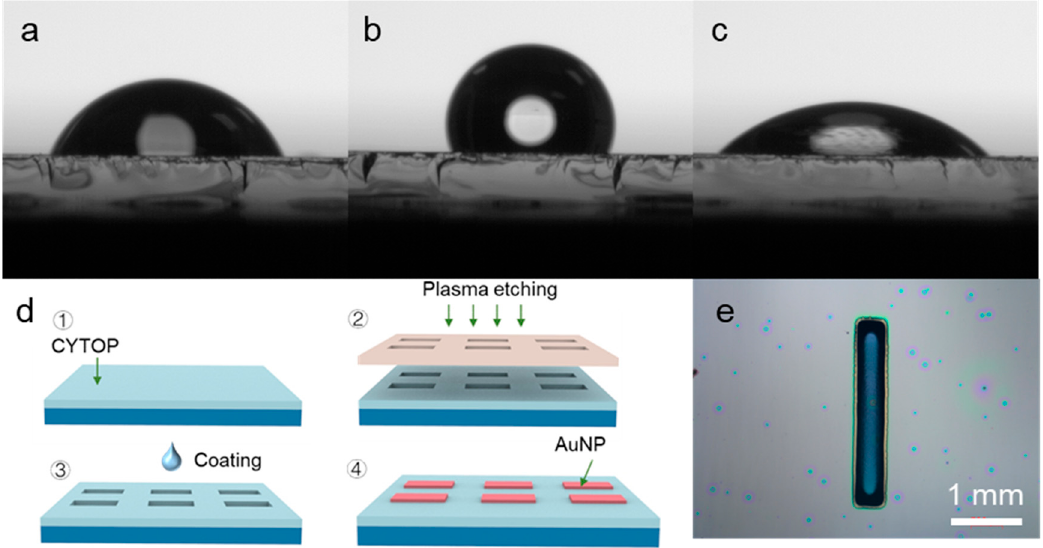
Figure 2. Contact angle images of the glass substrate at the different stations: ( a ) untreated, ( b ) coating Cytop, ( c ) after plasma treatment. ( d ) Schematic illustration of the fabrication of the patterned NPG electrodes. ( e ) Optical microscope image of the patterned NPG electrode.